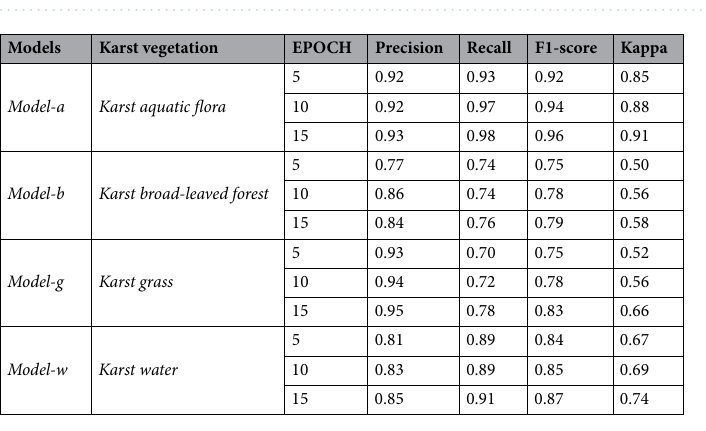
Table 3. Classification accuracies of single-class SegNet models with different EPOCH values using testing data.